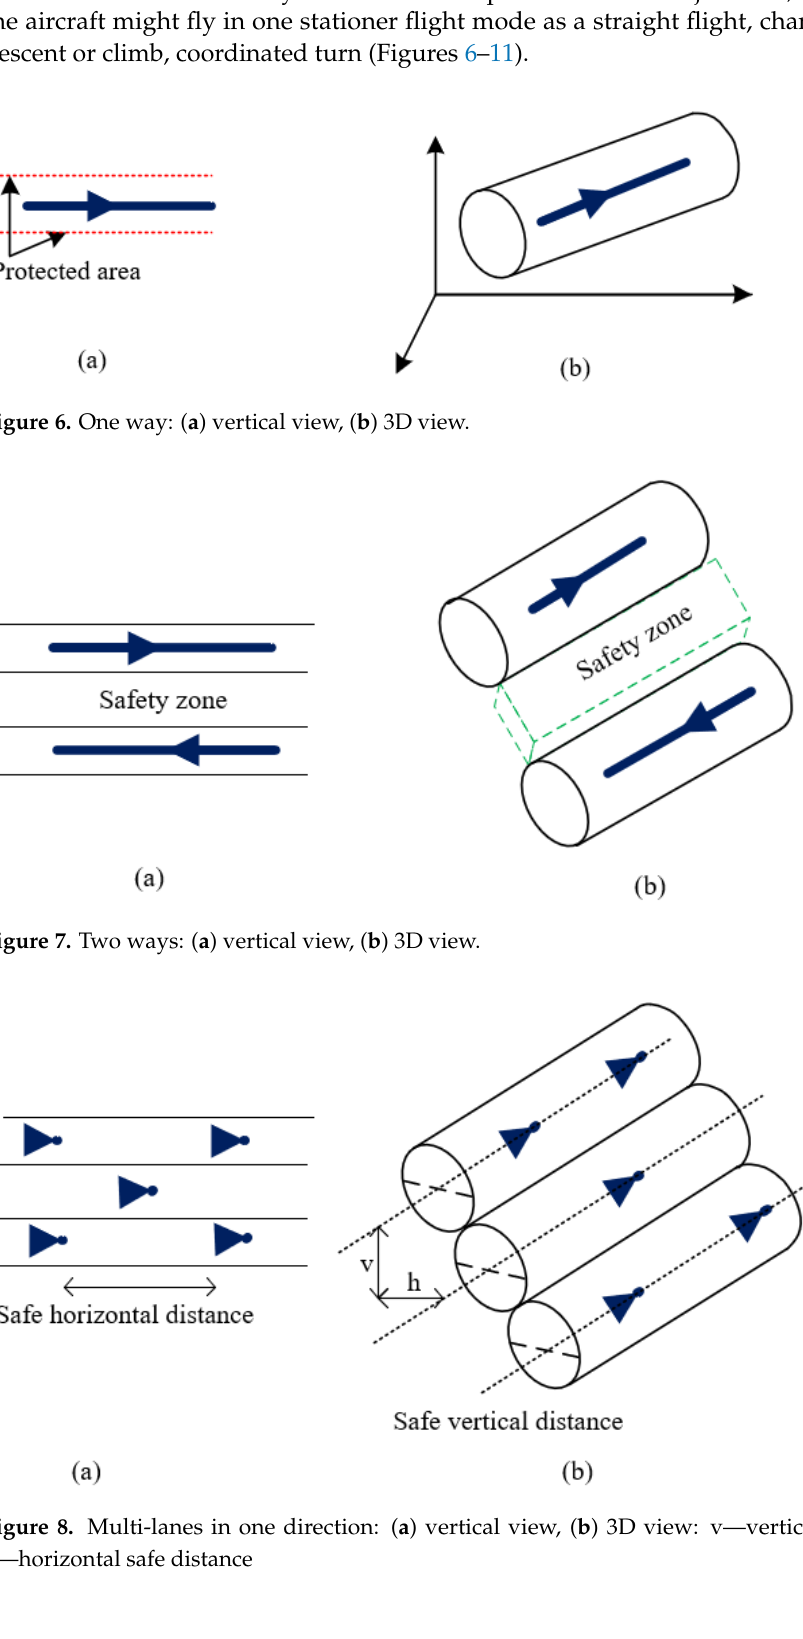
Figure 9. Multi-lanes in two ways: ( a ) vertical view, ( b ) 3D view. Figure 10. Turning: ( a ) in one way at the same altitude, ( b ) in two ways at the same height.